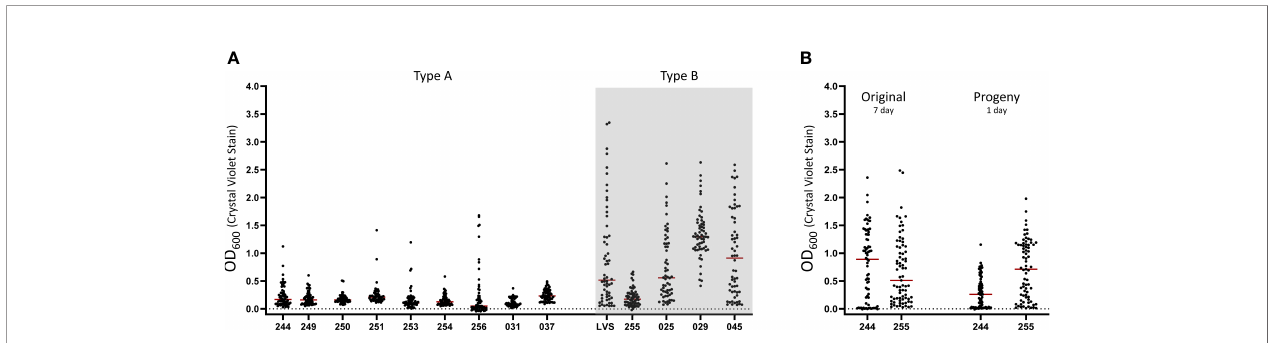
FIGURE 3 | Stochastic bio fi lm formation is conserved across a diverse panel of fully virulent F. Tularensis type A and B isolates. (A) The ability of each isolate was assessed using crystal violet staining after 7 days of culturing in CDM in fully virulent Type A (white background) and B (grey background) isolates. LVS was included as a positive control in each assay. (B) Replicate plates were inoculated from the original 7 day plates of FRAN244 and FRAN255 (Type A and B isolates, respectively) to assess bio fi lm formation in progeny cells. Bio fi lm development was assayed at 24 h post inoculation. Each point graphed represents an individual well in an experiment. The red bar indicates the median value after at least 3 independent